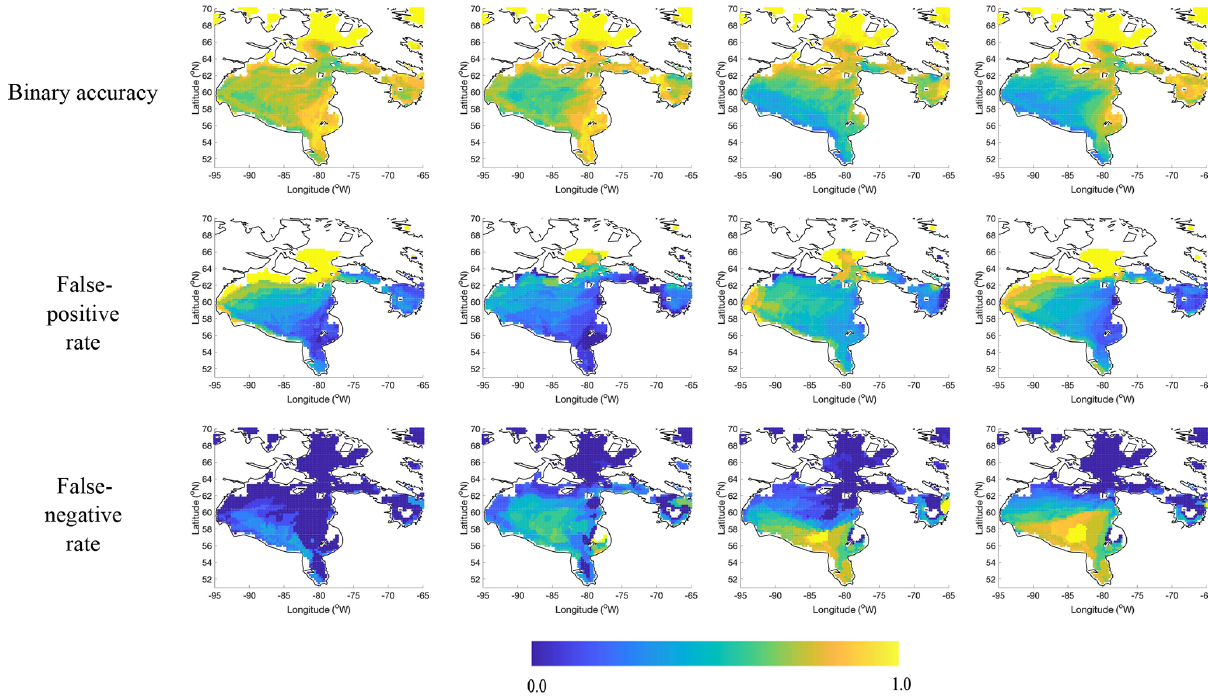
Figure 15. The columns from left to right are as follows: Climate Normal, S2S, Basic model, and Augmented model. Binary accuracy, false-positive rate, and false-negative rate calculated using data from forecasts launched between 1–31 October 2016 and 1–31 October 2017 at 45 lead days. These correspond to conditions from 15 November–16 December 2016 and 15 November–16 December